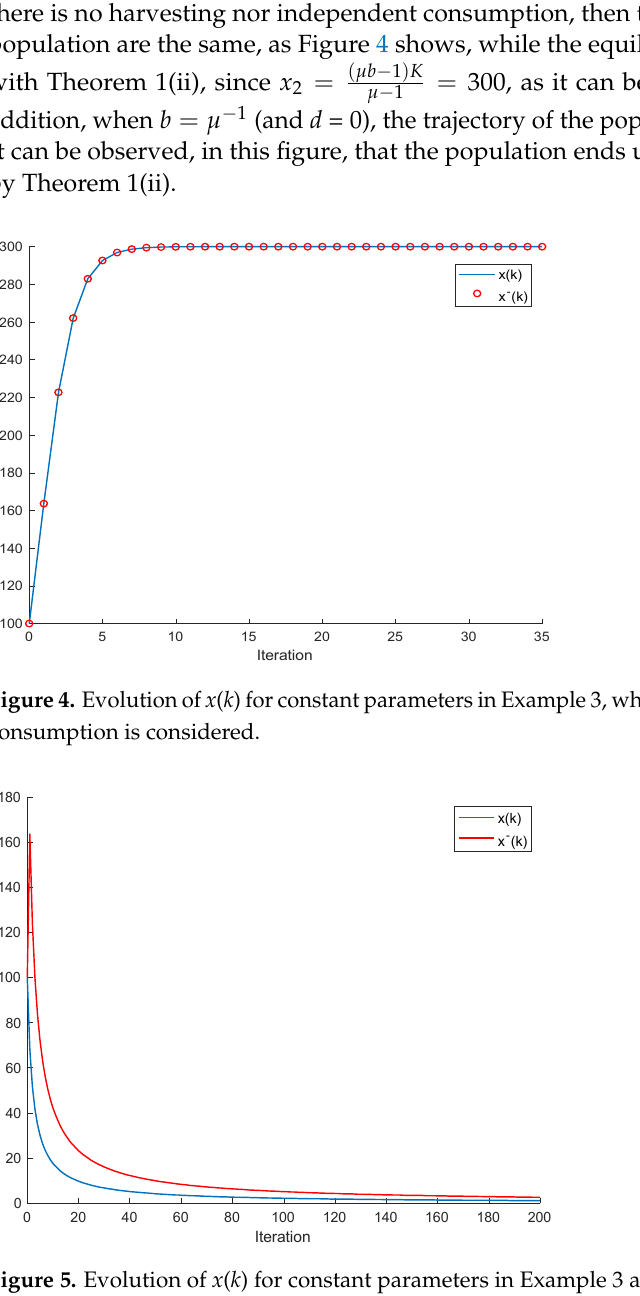
Figure 5. Evolution of x ( k ) for constant parameters in Example 3 and b = µ − 1 with d = 1